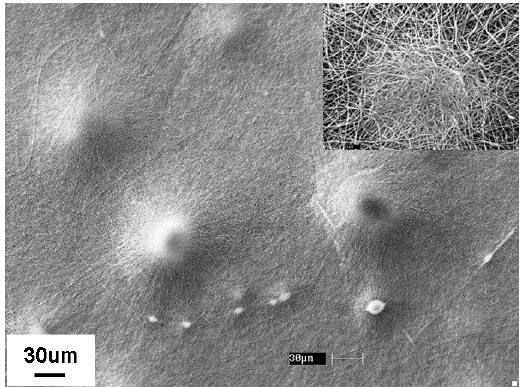
Figure 5. Typical stress-strain plots of nylon 6 non-woven fiber mats electrospun from 20 wt % solutions before and after formic acid vapor exposure for 30 min at room temperature. Table 3. Tensile properties of nylon 6 non-woven fiber mats electrospun from 20 wt % solutions before and after formic acid vapor exposure for 30 min at room temperature.